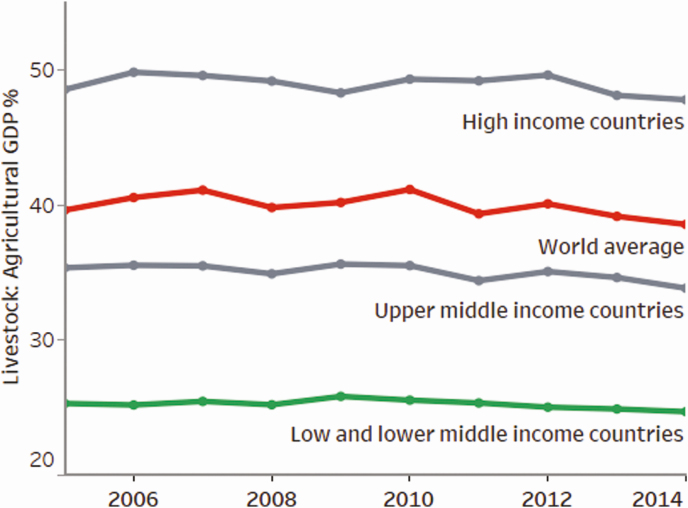
Contribution of the livestock sector to agricultural GDP.
Source: LD4D (2018).